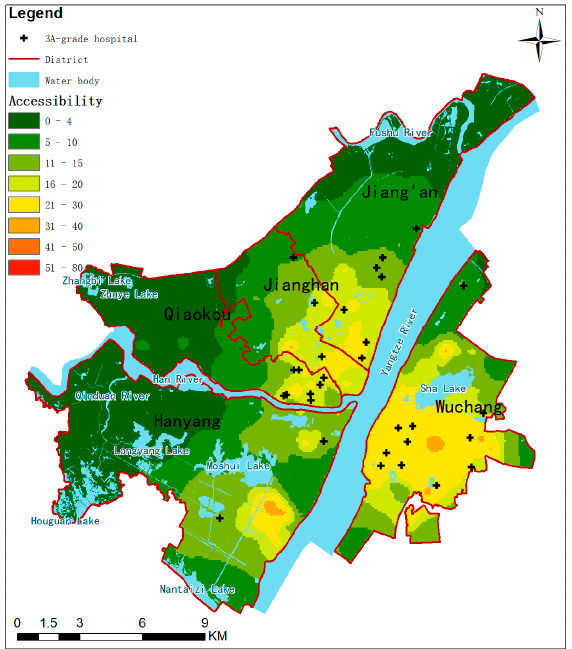
Figure 4. Accessibility of medical facilities ( d s = 10 km).